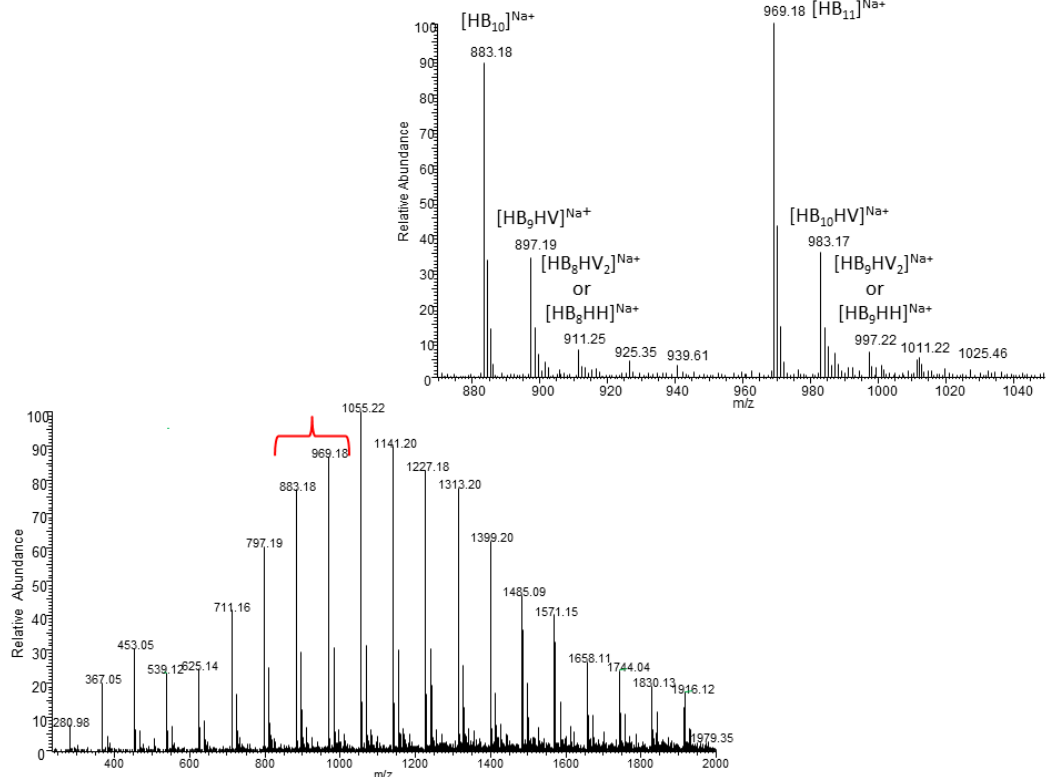
Figure 4. The ESI-MS spectrum (positive-ion mode) of the PHA oligomers, obtained via partial thermal degradation of the biopolyester obtained using TSB/O-PEW as a carbon source, together with an extended spectral range of m / z 870–1050.